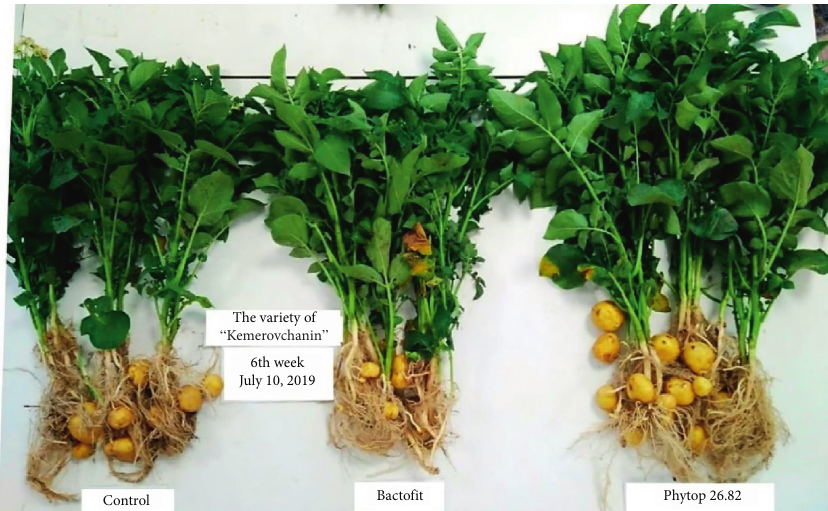
Figure 4: The formation of stolons and potato tubers under the influence of biological products (at the 6th counting week)—the largest number of tubers on potatoes treated with the microbial mixture Phytop 26.82.